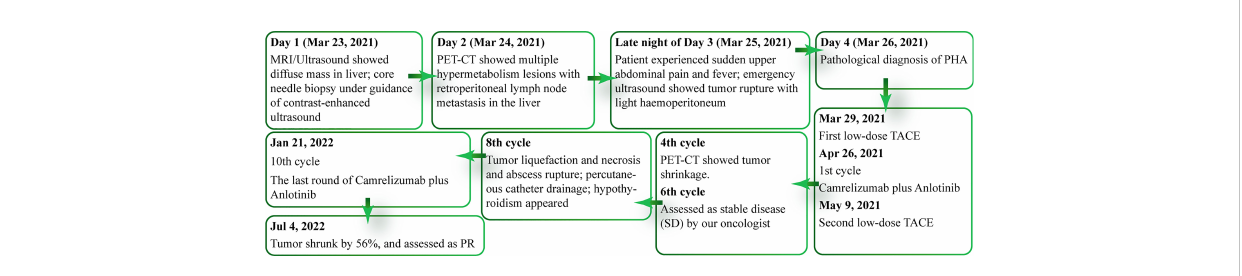
FIGURE 4 Timeline of patient's clinical